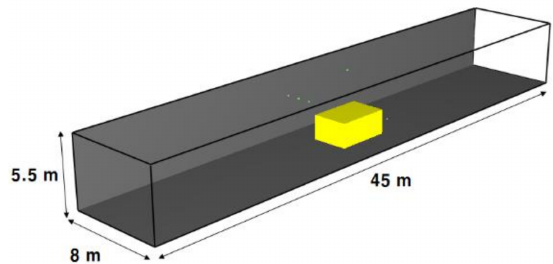
Figure 1. Dimension of tunnel and position of fire in tunnel modelling.